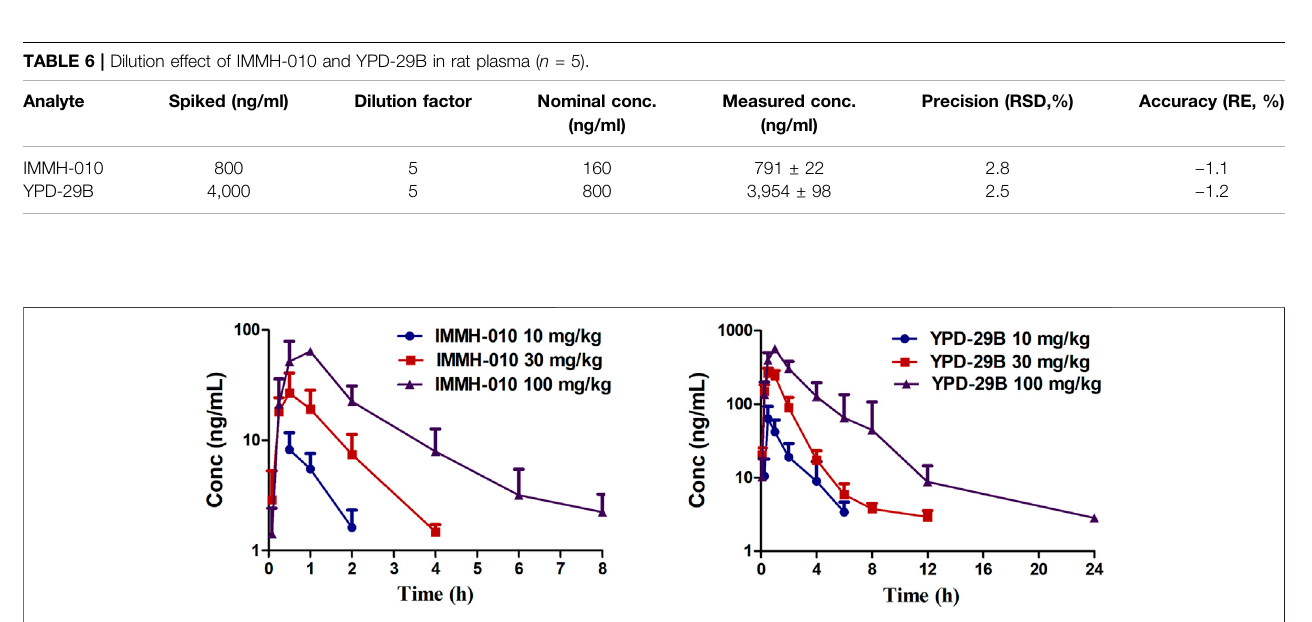
TABLE7| PharmacokineticparametersofIMMH-010andYPD-29Binratsplasmaafterasinglei.g.administrationofIMMH-010maleateat10,30and100 mg/kg.Dataare expressed as mean ± SD or median (range) ( n (cid:1) 5). Parameters